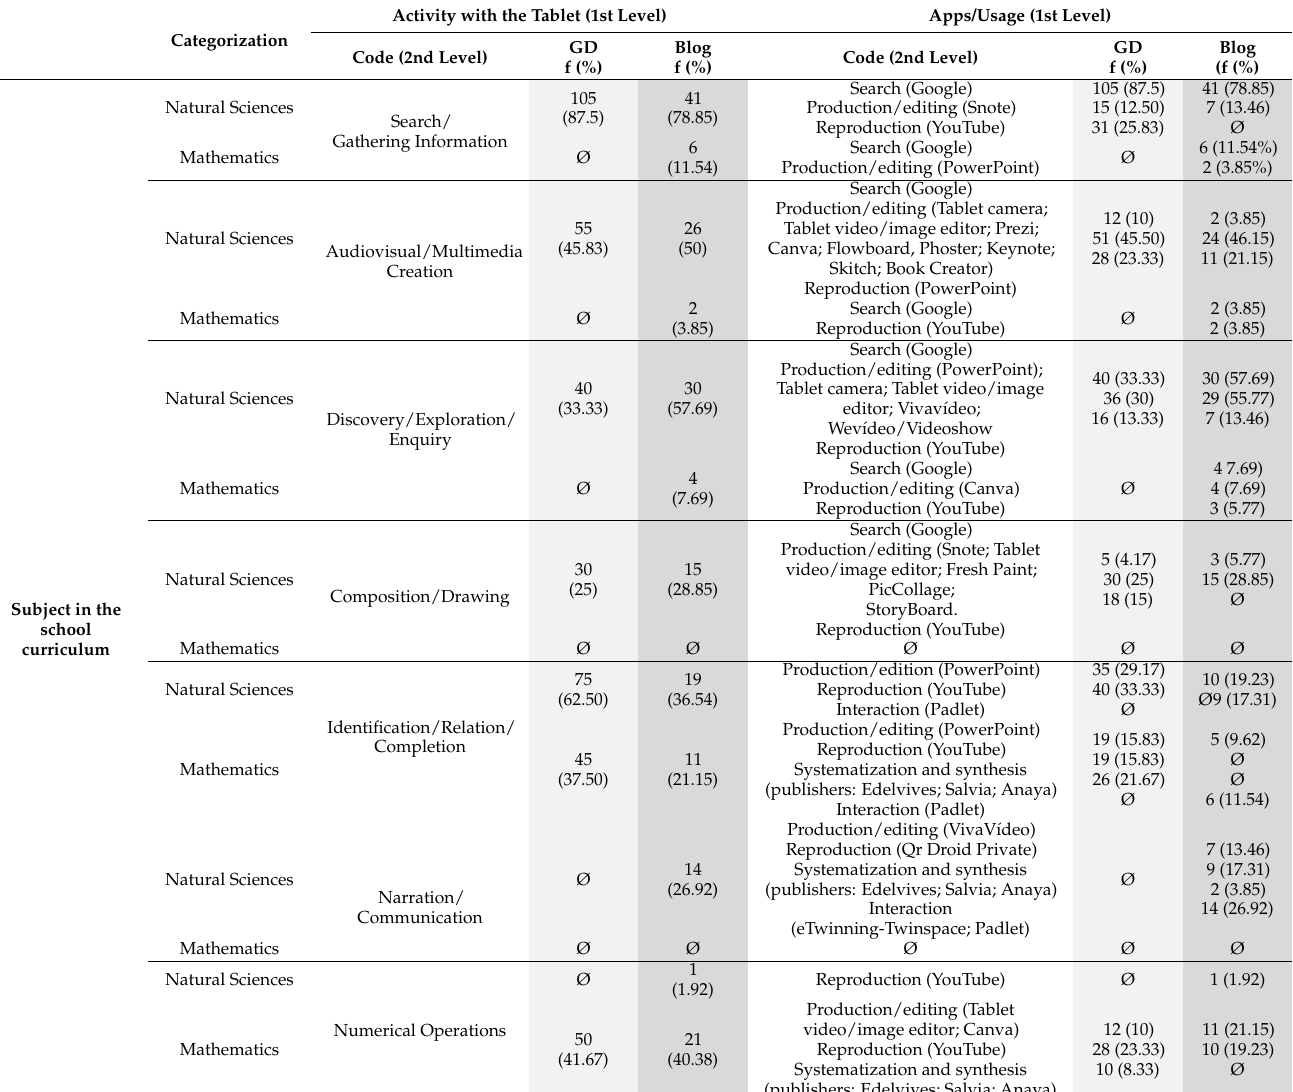
Table 2. Typology of activities with the tablet in the natural sciences and